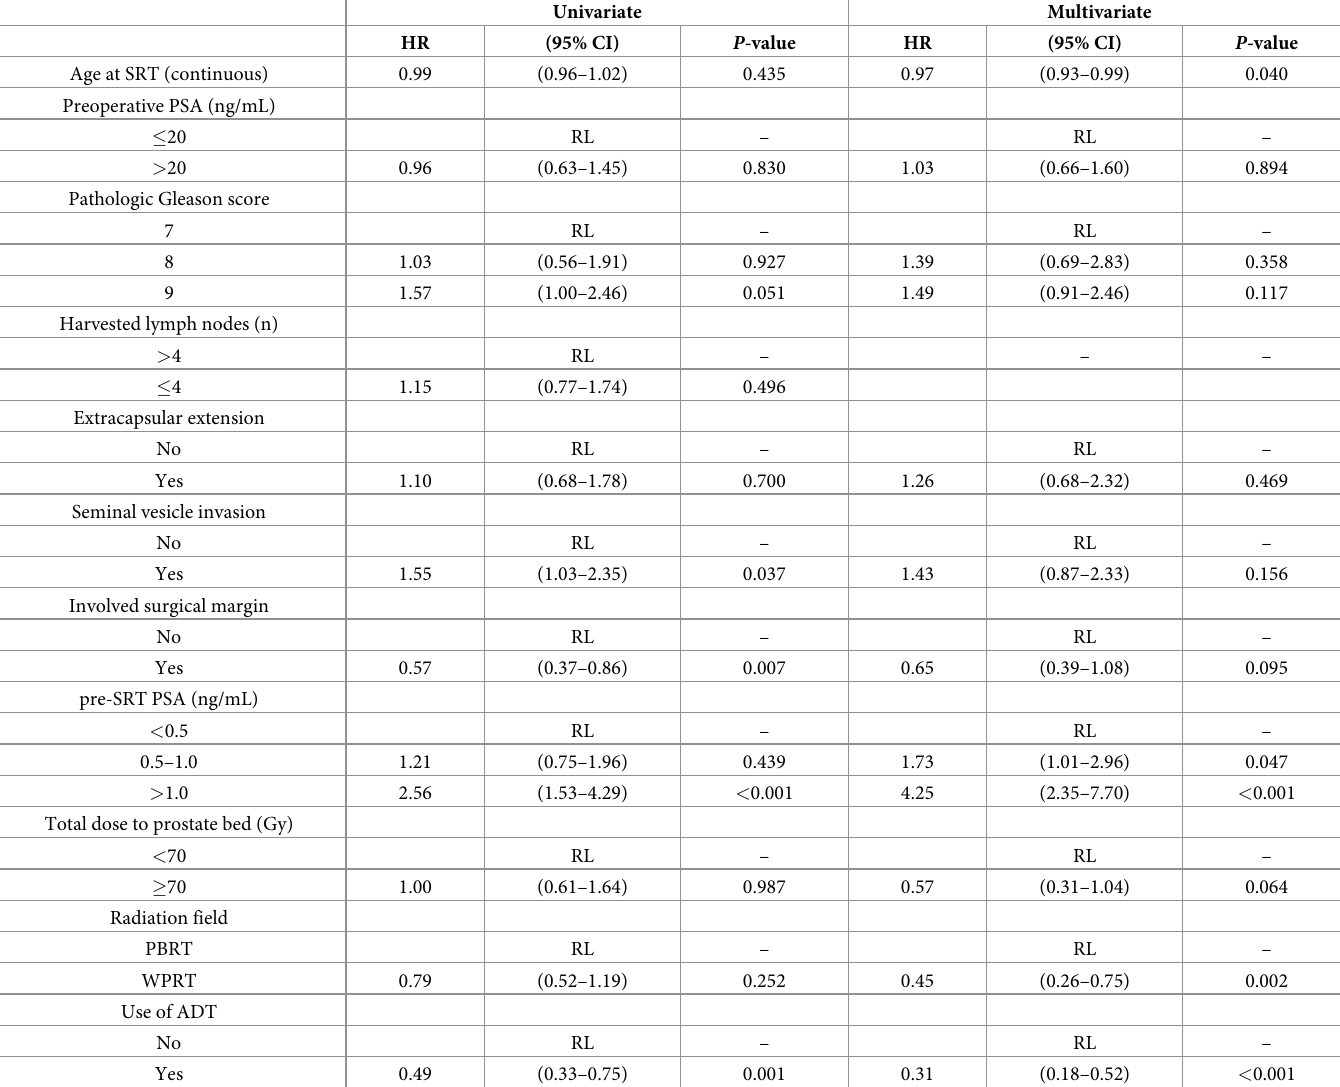
Table 2. Univariate and multivariate analysis for biochemical relapse-free